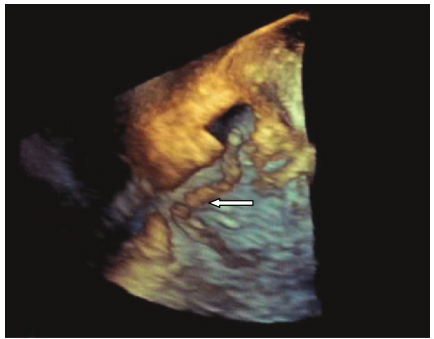
Figure 3: Three-dimensional view of the thrombus.